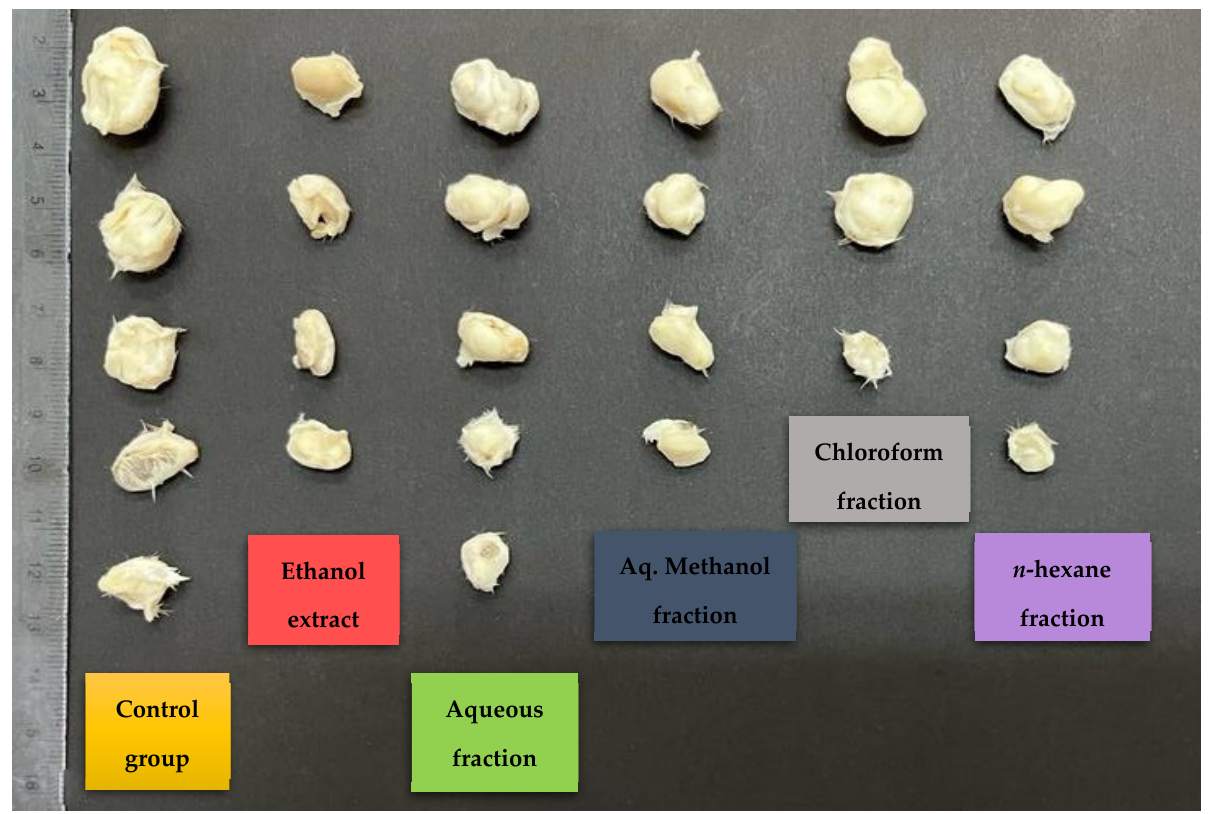
Figure 4. Effects of X. spinosum extract and fractions on tumor size and cure percentage. Treatment with X. spinosum resulted in a smaller tumor size and higher cure percentage compared to the negative control ( n = 7 mice in each group).